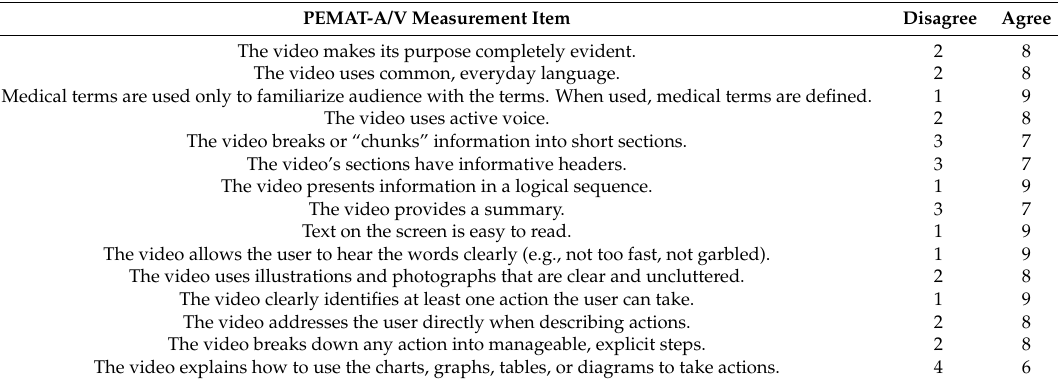
Table 2. Pharmacists’ The Patient Education Materials Assessment Tool for Audio-Visual Materials (PEMAT-A/V)